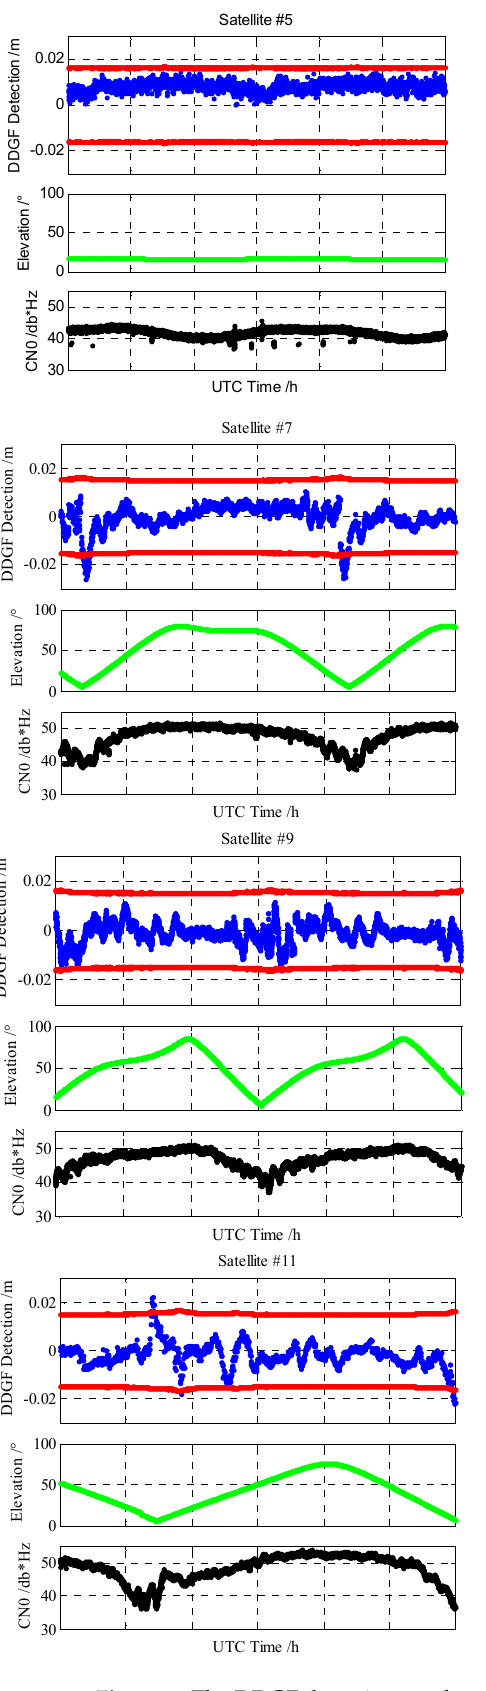
Figure 8. The DDGF detecting results together with the elevation angle and CN0.